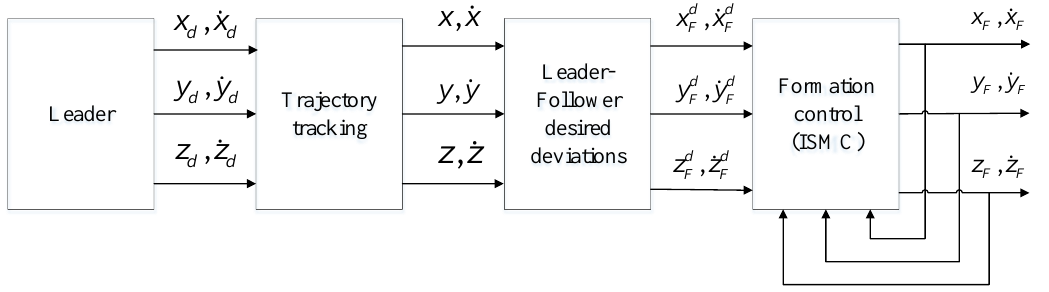
Figure 4. Formation control system structure.